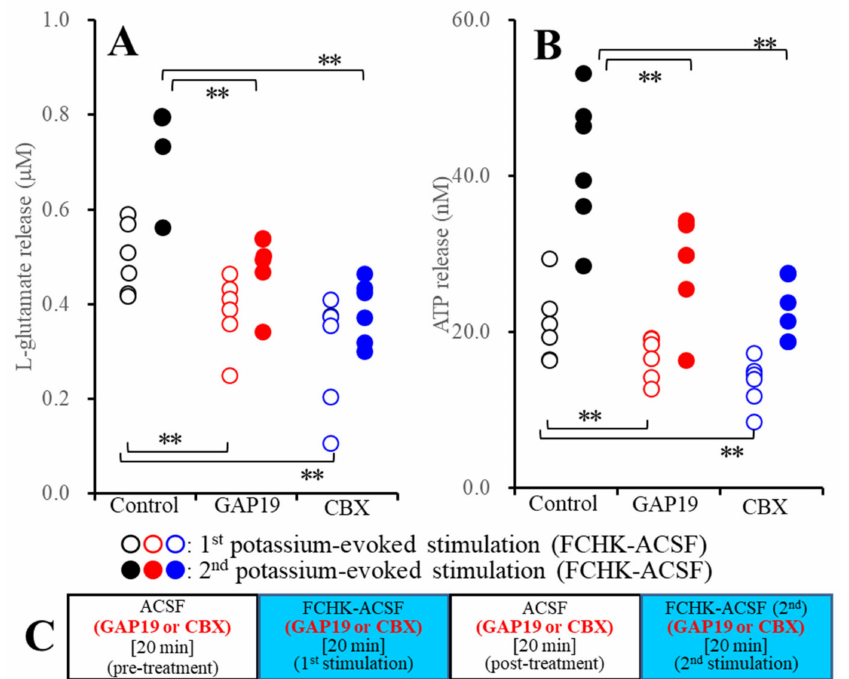
Figure 3. E ff ects of the hemichannel inhibitors (20 µ M GAP19 and 100 µ M CBX) on the repetitive K + -evoked (FCHK-ACSF) astroglial release of ( A ) l -glutamate, ( B ) ATP, and ( C ) the experimental design. Ordinate: mean ± SD ( n = 6) of the levels of l -glutamate ( µ M) and ATP (nM). ** p < 0.01 relative to the control by two-way ANOVA with Tukey’s post-hoc